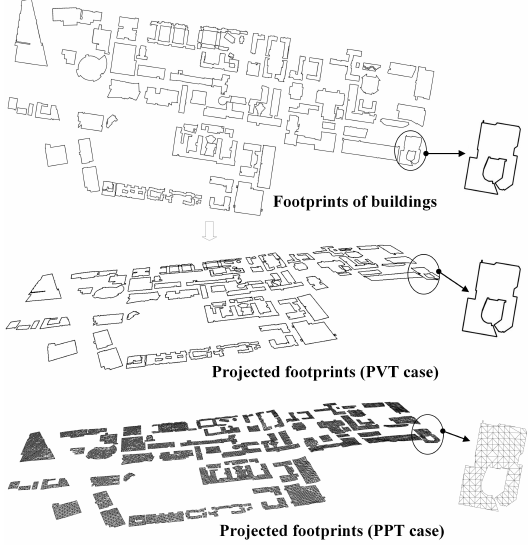
Figure 11. The projected footprints on the terrain.